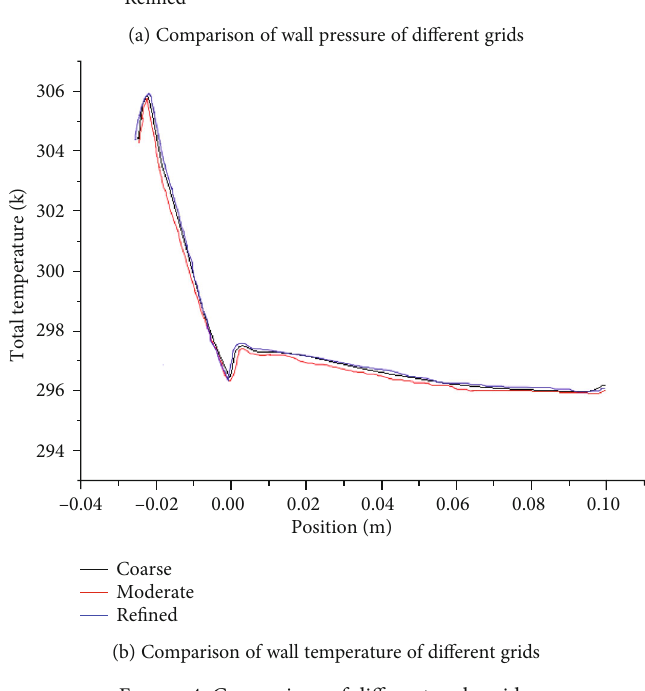
Figure 4: Comparison of di ff erent scale